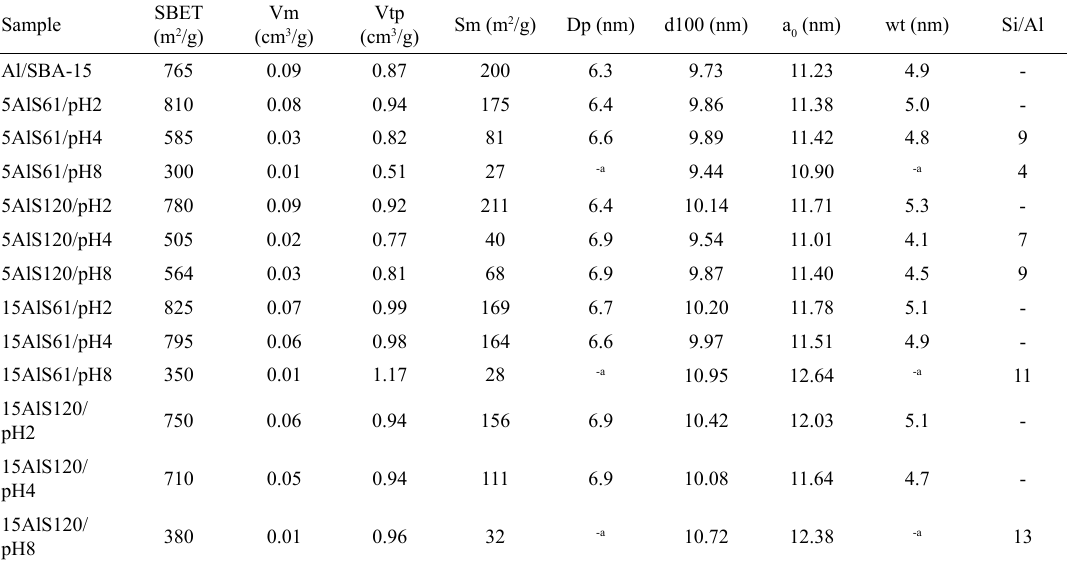
Table 2. Textural properties of Al/SBA-15 materials synthesized by direct route and samples obtained by pH adjustment.